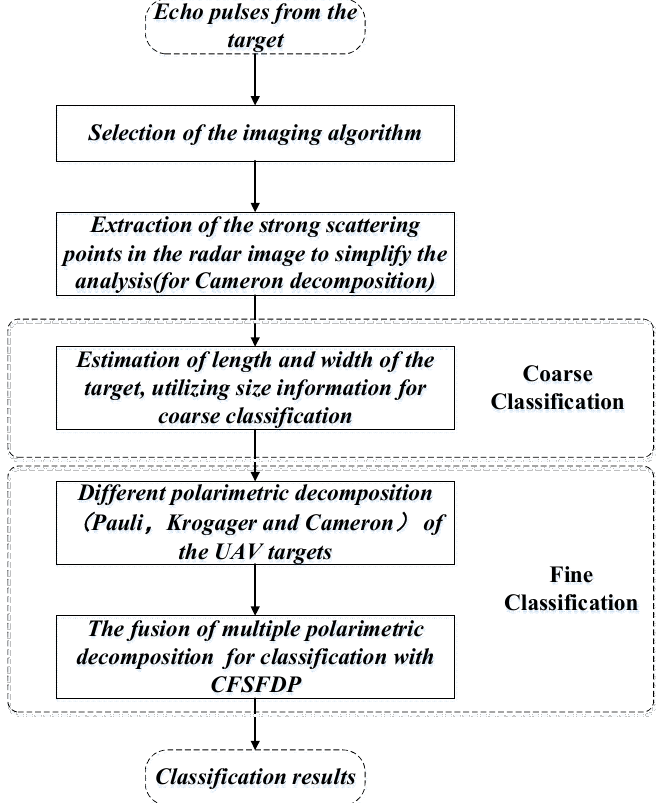
Figure 3. The flowchart of the classification algorithm with CFSFDP for UAVs.